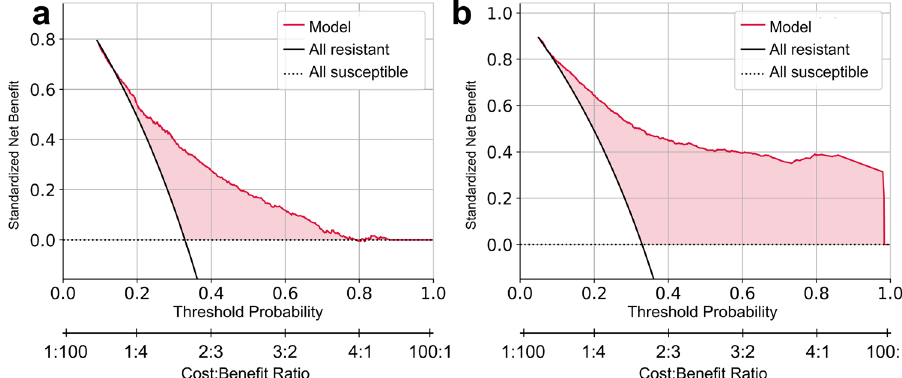
Fig. 4 agnostic and gnostic decision curves. agnostic ( a ), gnostic ( b ). The standardized net bene fi t is plotted against the threshold probability and cost- bene fi t ratio of deciding that an infection is resistant to cipro fl oxacin. Curves of the bene fi t when assuming all infections are susceptible (dashed horizontal line), all infections are resistant (black curve), and relying on the ensemble model predictions (red curve) are plotted. Positive differences in standardized net bene fi t of the model predictions vs the all resistant and all susceptible curves are shaded in